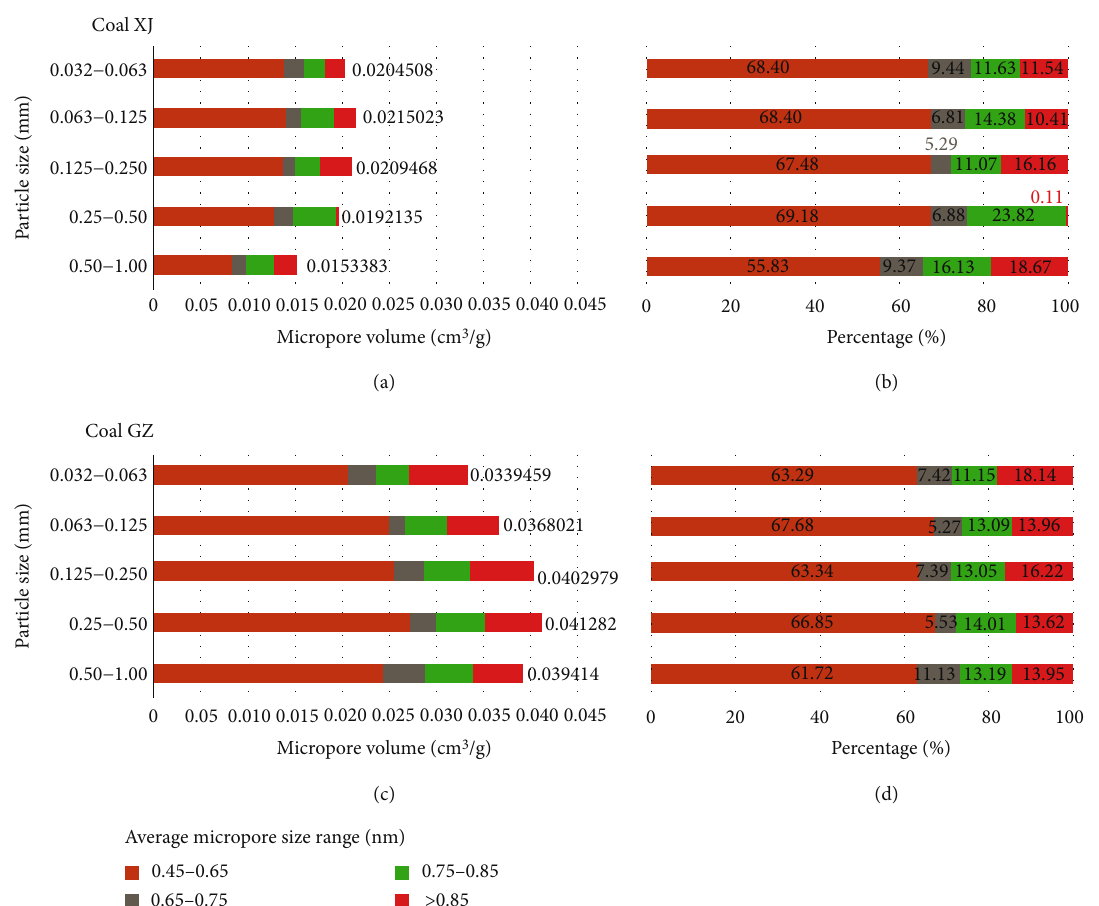
Figure 10: Horizontal and stacked bar charts of micropore volume and proportion corresponding to speci fi c pore size ranges for Coal XJ (a, b) and Coal GZ (c, d). Micropore size ranges 0.45 – 0.65, 0.65 – 0.75, 0.75 – 0.85, and >